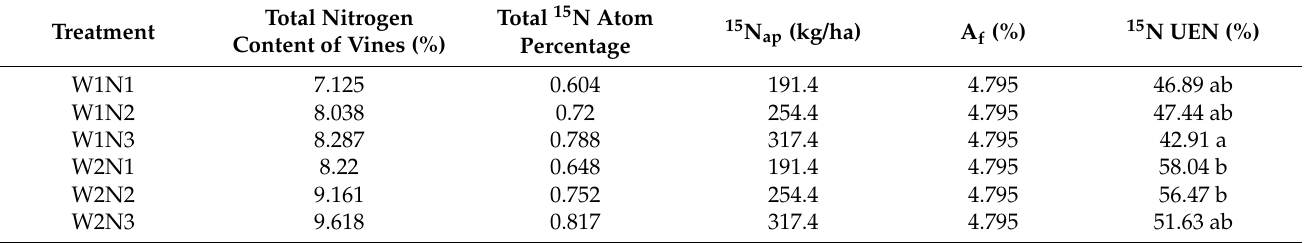
Table 7. Comparison of the 15 N utilization rates of the different